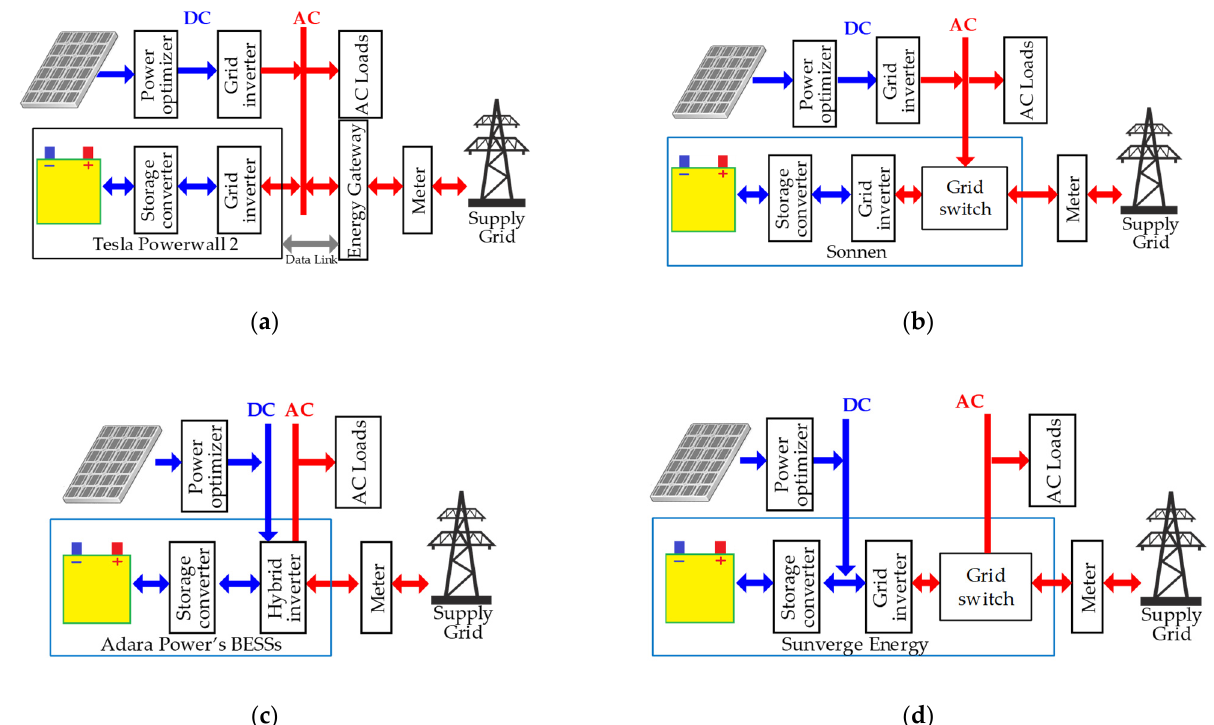
Figure 4. Typical examples of system configurations of different BESs: ( a ) Tesla Powerwall 2, ( b ) SonnenBatterie, ( c ) Adara Power-Residential and ( d ) Sunverge energy.